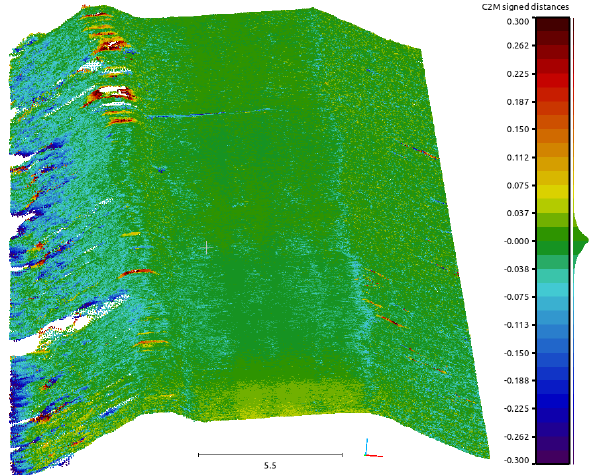
Figure 12: Repeatability test led on the 2014 acquisition. The test shows that the imprecision occur mostly on the areas covered with dense vegetation and on the